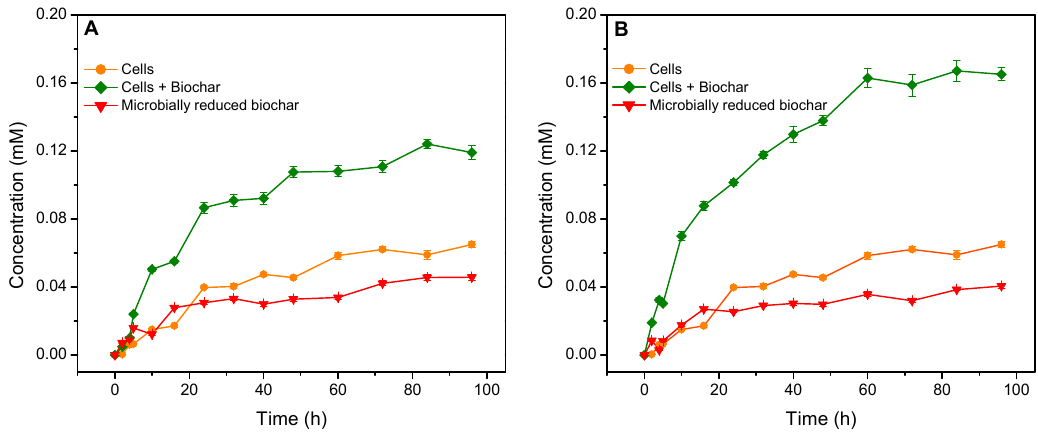
Figure 4. Concentration changes of aniline detected in different treatment systems with incubation time. Biochars in ( A ) and ( B ) were prepared using peanut stalks from the plot without Fe addition and from the plot with Fe addition, respectively.